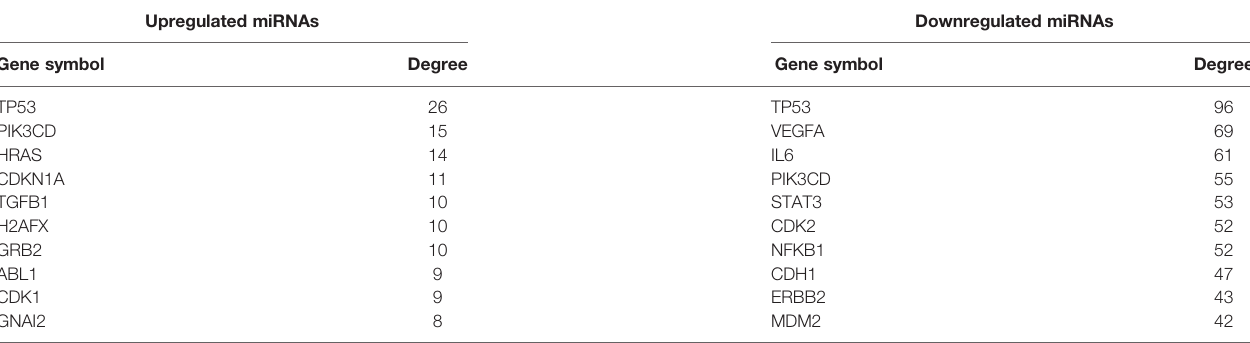
PPI, protein-protein